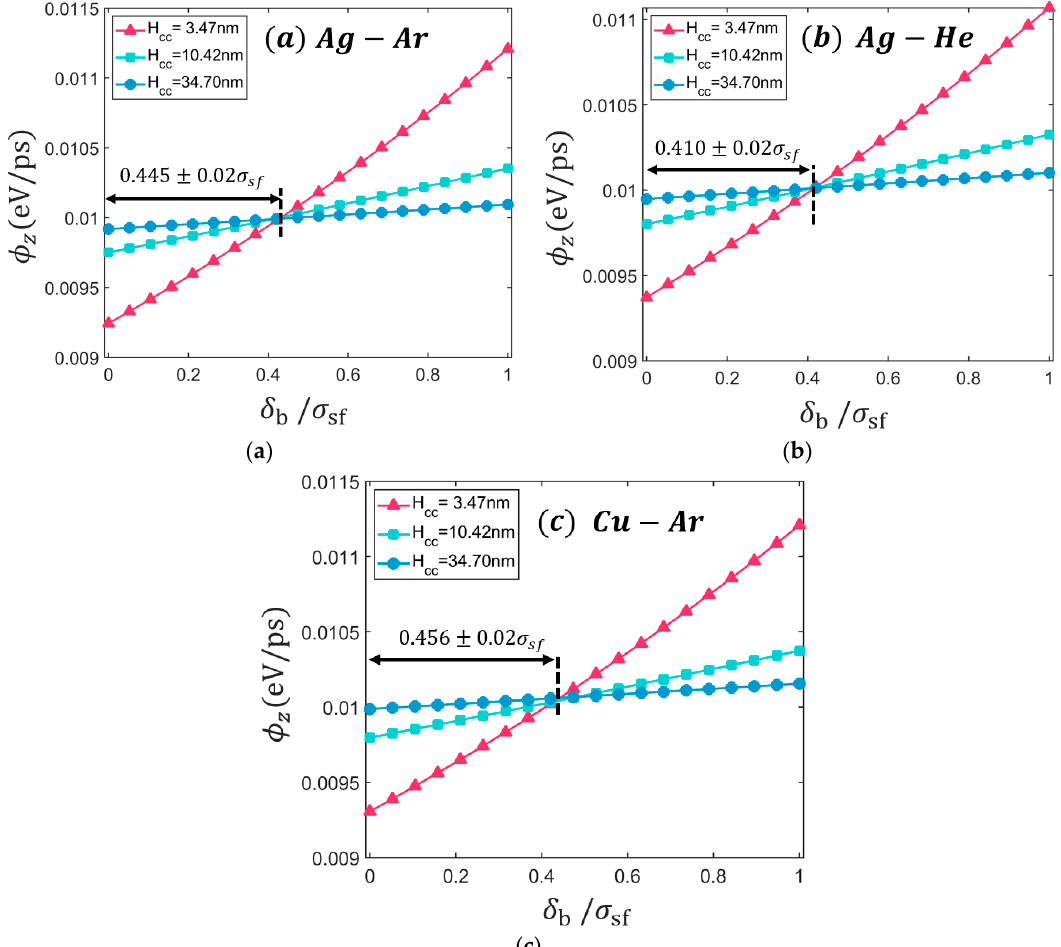
Figure 6. The estimated heat flux with respect to the location of the defined solid / fluid boundary ( δ b ) for ( a ) Ag-Ar interface, ( b ) Ag-He interface, and ( c ) Cu-Ar interface with three different channel heights. The temperature maintained at T = 100 K for all systems.